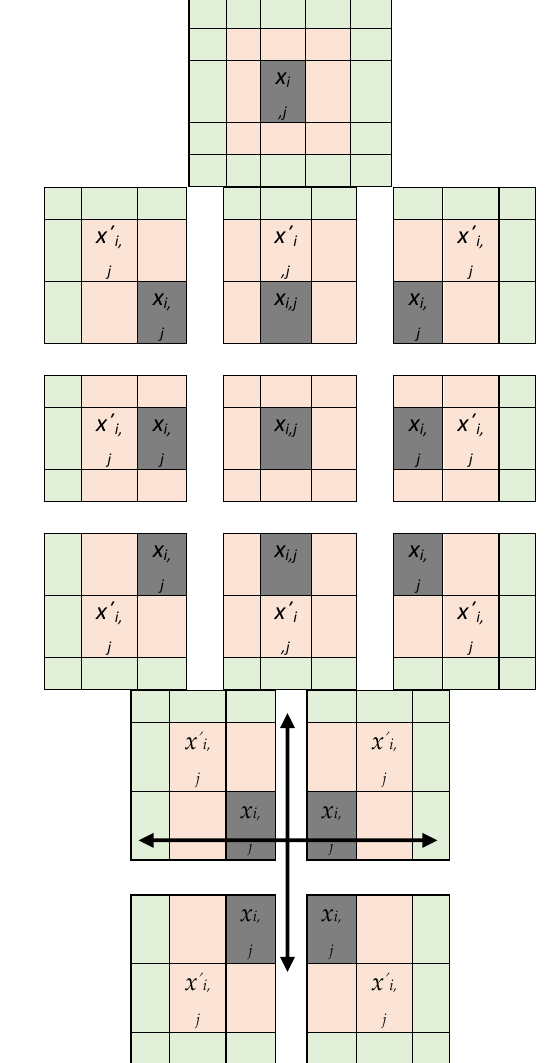
Figure 2. ( a ) Shows a 5 × 5 conceptual window formed by padding additional rows and columns to original 3 × 3 image window. ( b ) Shows a divide and conquer strategy mechanism: division of a 5 × 5 kernel to nine (09) subsets of 3 × 3 size kernels with new central locations 𝑥 𝑖,𝑗′ . ( c ) Shows a new contextual model for noise detection.